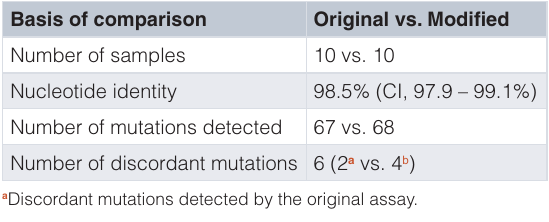
Table 2. Summary of the paired sequence comparisons performed by the original and the modified assay. Basis of comparison